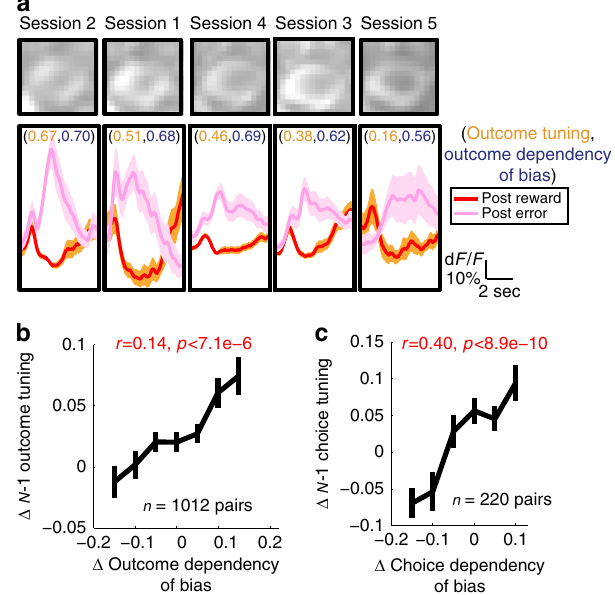
Fig. 5 History tuning of PPC neurons re fl ects the history dependency of bias. a Top: a single neuron imaged in fi ve separate sessions, sorted in the descending order of the ( N − 1) trial outcome tuning strength. Bottom: pre- stimulus activity (mean ± s.e.m.; − 6 to 0 s from stimulus onset) of the example neuron following reward and error trials. Each pair of numbers represents the tuning strength of the neuron for ( N − 1) trial outcome and outcome dependency of the internal bias (estimated as the accuracy of the partial model using only outcome information), respectively. Note that the outcome tuning is stronger in sessions in which the past outcome information has stronger contributions to the bias. b Between-session differences in ( N − 1) outcome tuning of the ITI activity of single neurons plotted against between-session differences in choice dependency on outcome information (Pearson correlation coef fi cient = 0.14, p < 7.1e-6). Neurons with signi fi cant outcome tuning in at least one of the two sessions are included. c The same as b but for the ( N − 1) trial